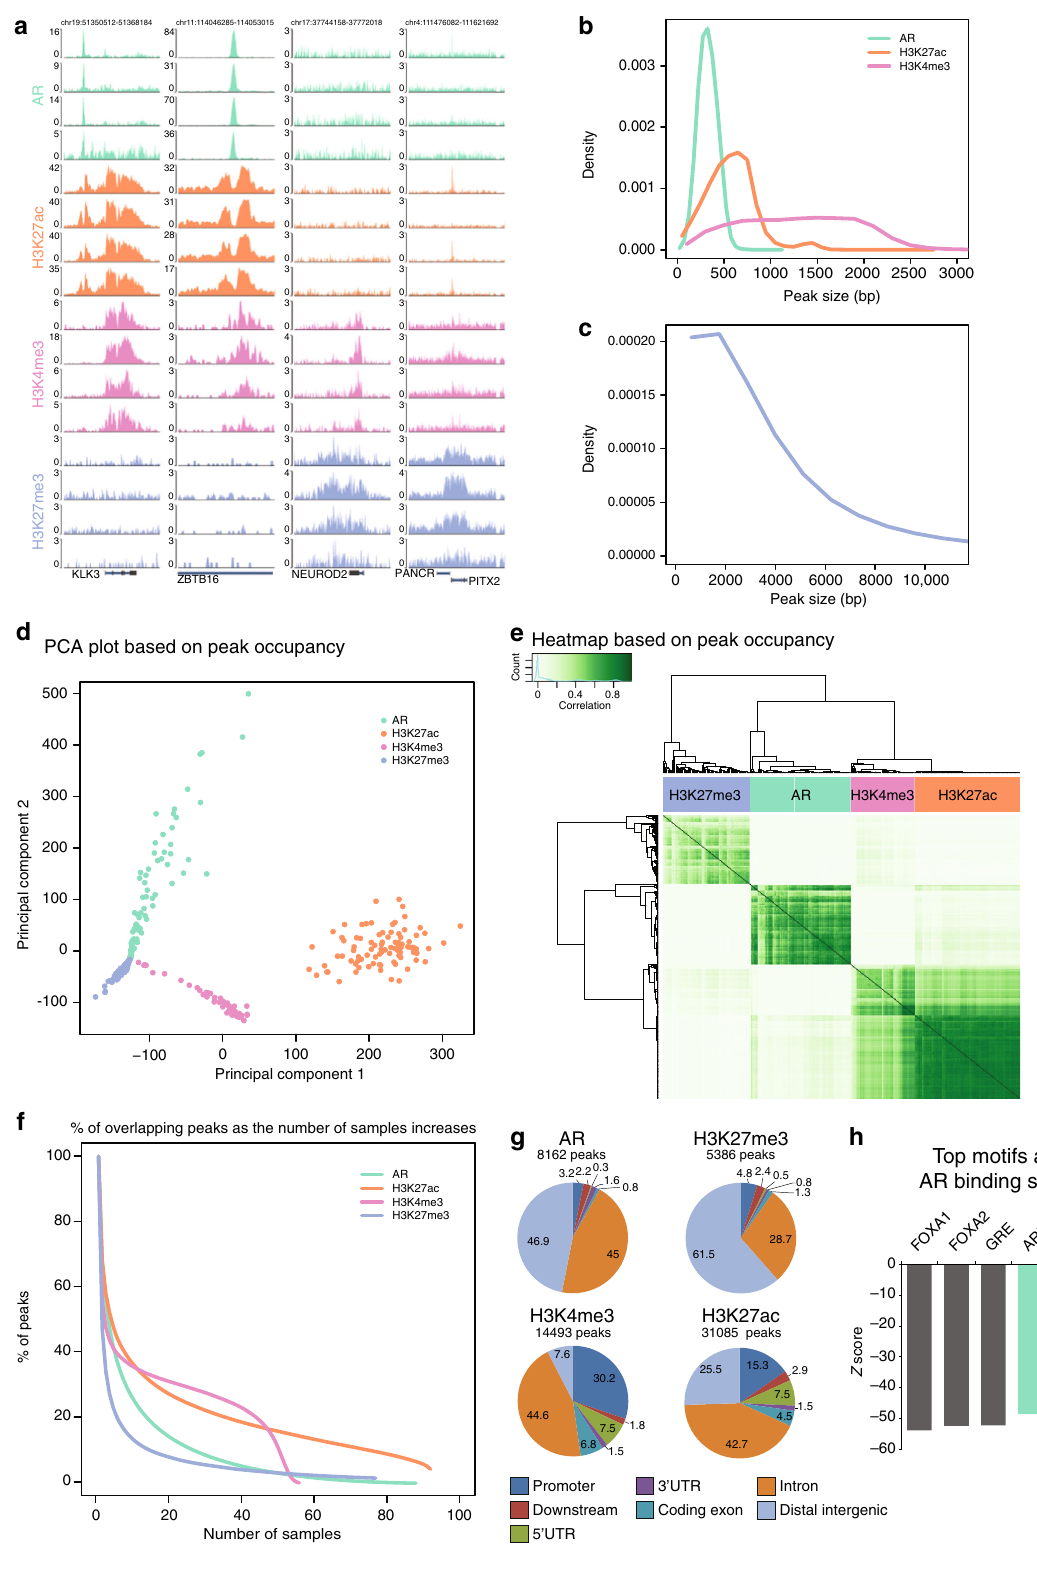
tumor with an ETV5 fusion transcript (1%). Transcriptome-wide analysis between low and high ERG expressing tumors revealed differential expression of previously identi fi ed ERG target genes (Supplementary Figure 9d), and two gene sets related to TMPRSS2 - ERG fusion from MSigDB show signi fi cant enrichment